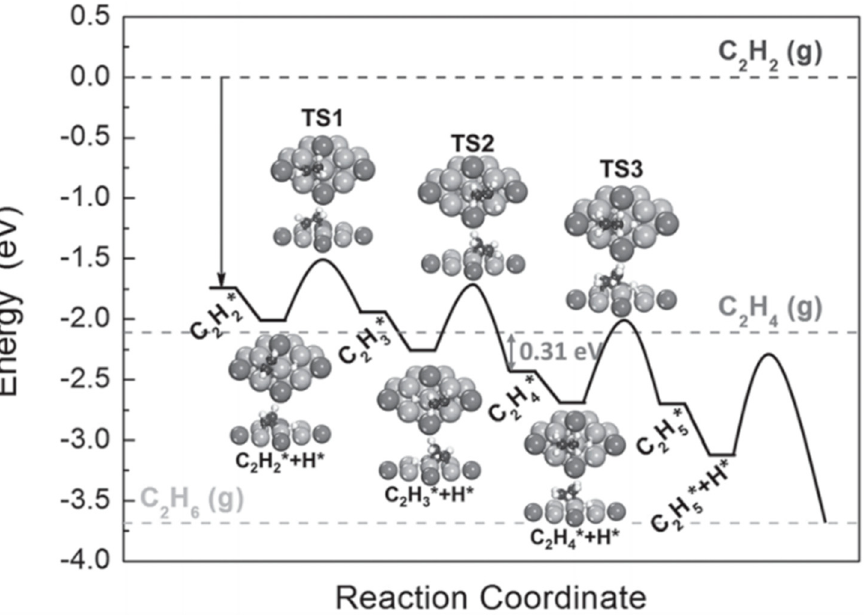
Figure 2. Potential energy diagram obtained from DFT calculations for the hydrogenation of acetylene to ethane on (111) of Ni 3 Ga. The geometries of the reaction intermediates, containing acetylene and ethylene, and transition states along the reaction pathway are displayed in the inset. The Ni, Ga, C, and H atoms are shown by the gray, dark gray, black, and white balls, respectively. Adapted from [44] with permission of Wiley-VCH, copyright 2016.